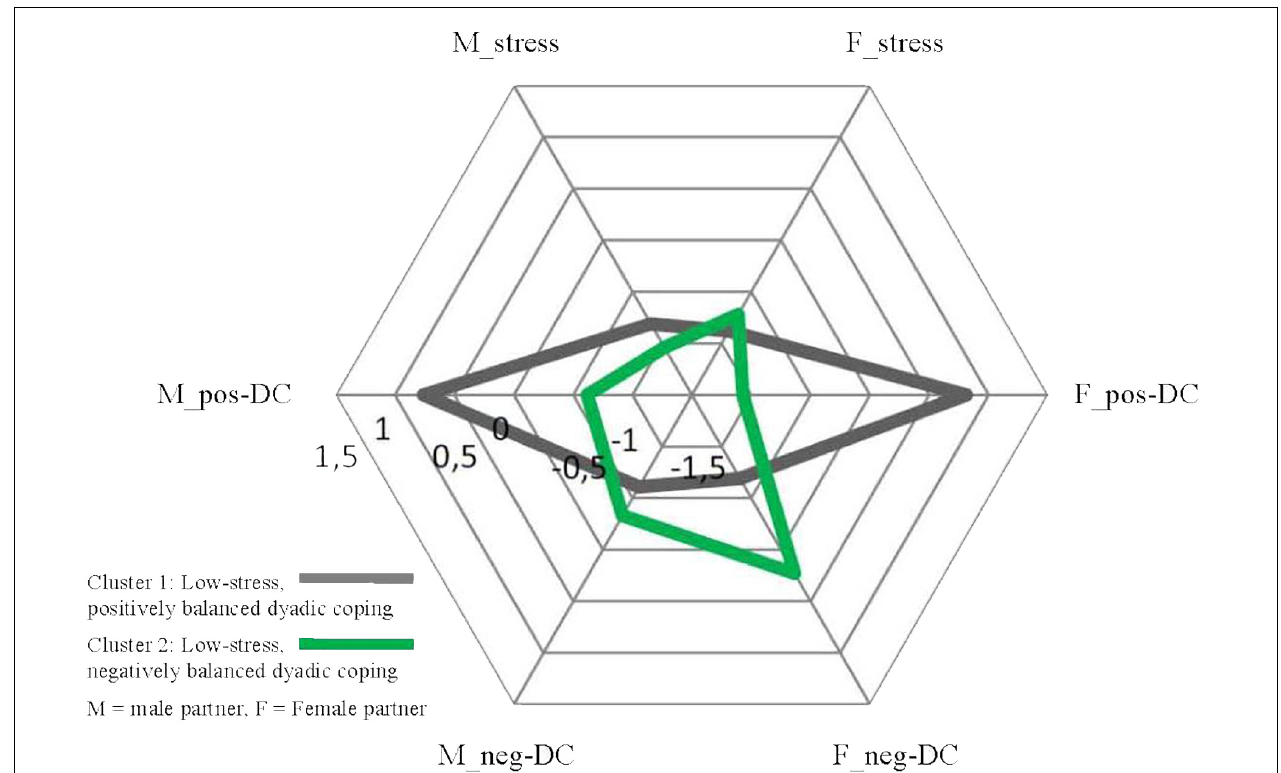
FIGURE 1 | Low-stress couples: Cluster centers of Cluster 1 and 2, z-scores.